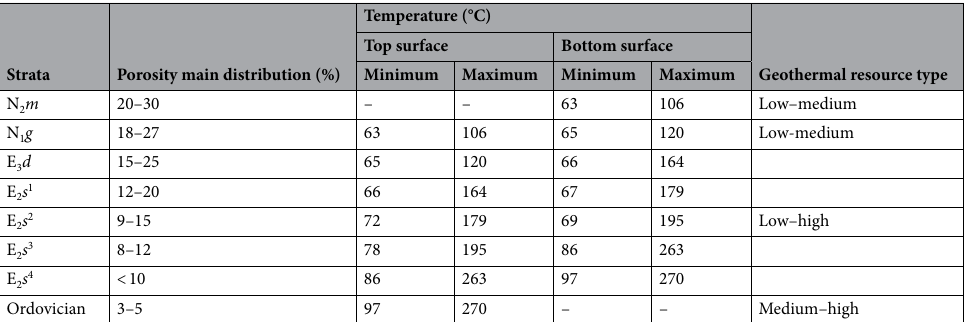
Table 1. Geothermal resources for the strata in the Dongpu